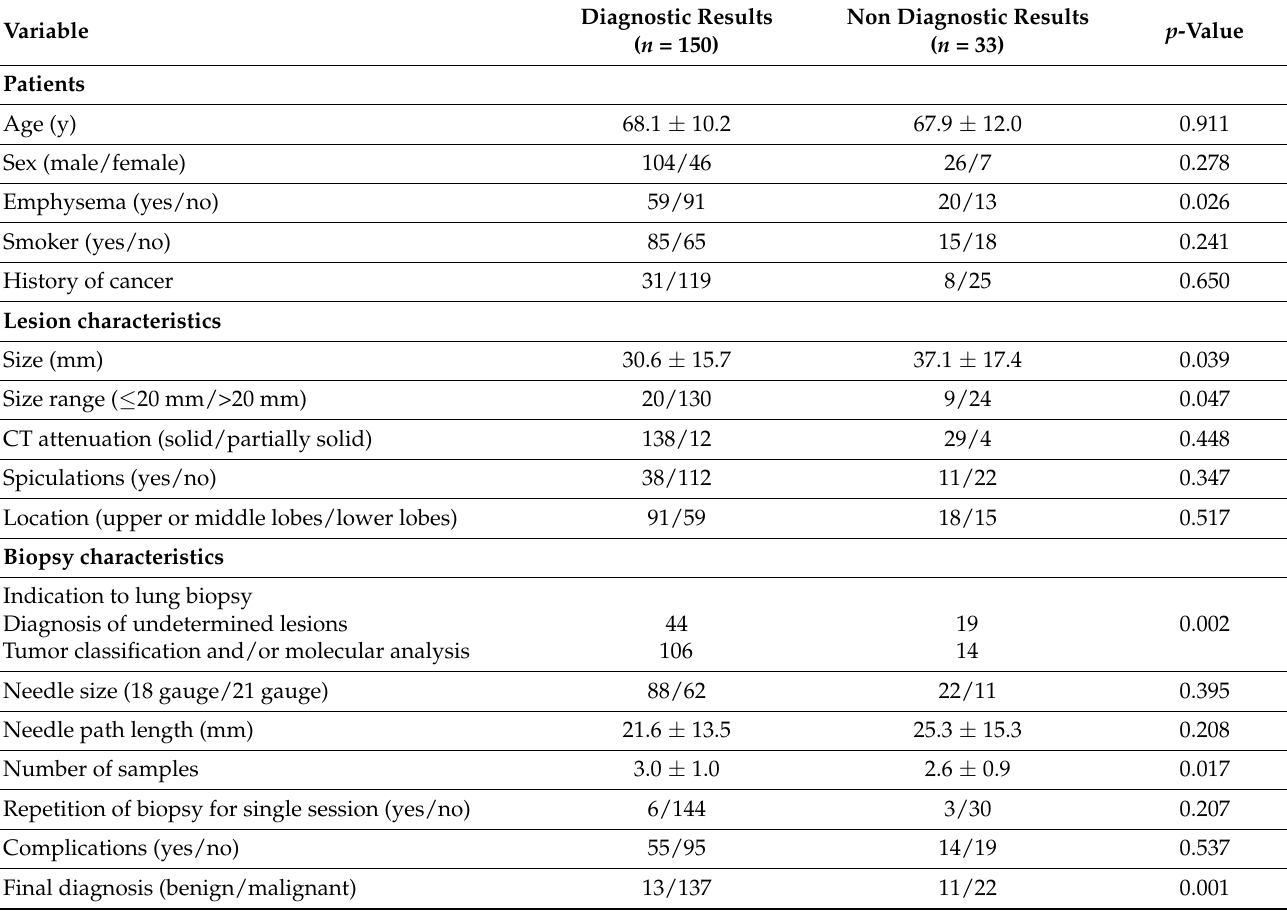
Table 2. Comparison between biopsies with diagnostic and nondiagnostic results.